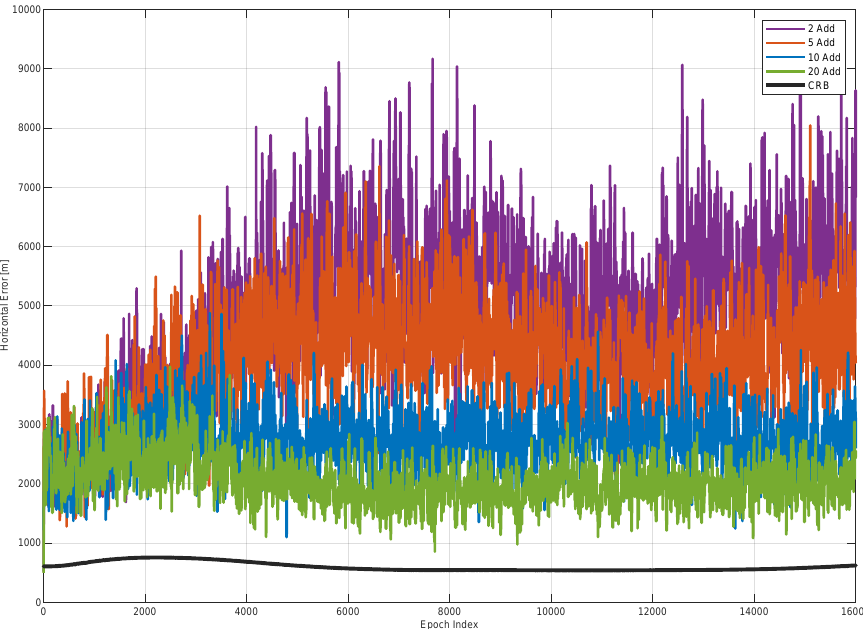
Figure 14. Horizontal Error as a function of the time epoch for four different configurations of the receiving network: BL+2Rx (purple), BL+5Rx (red), BL+10Rx (blue) and BL+20Rx (green). The horizontal error for each configuration and the horizontal CRB (black) are computed in each point of the trajectory in order to account for the different geometric